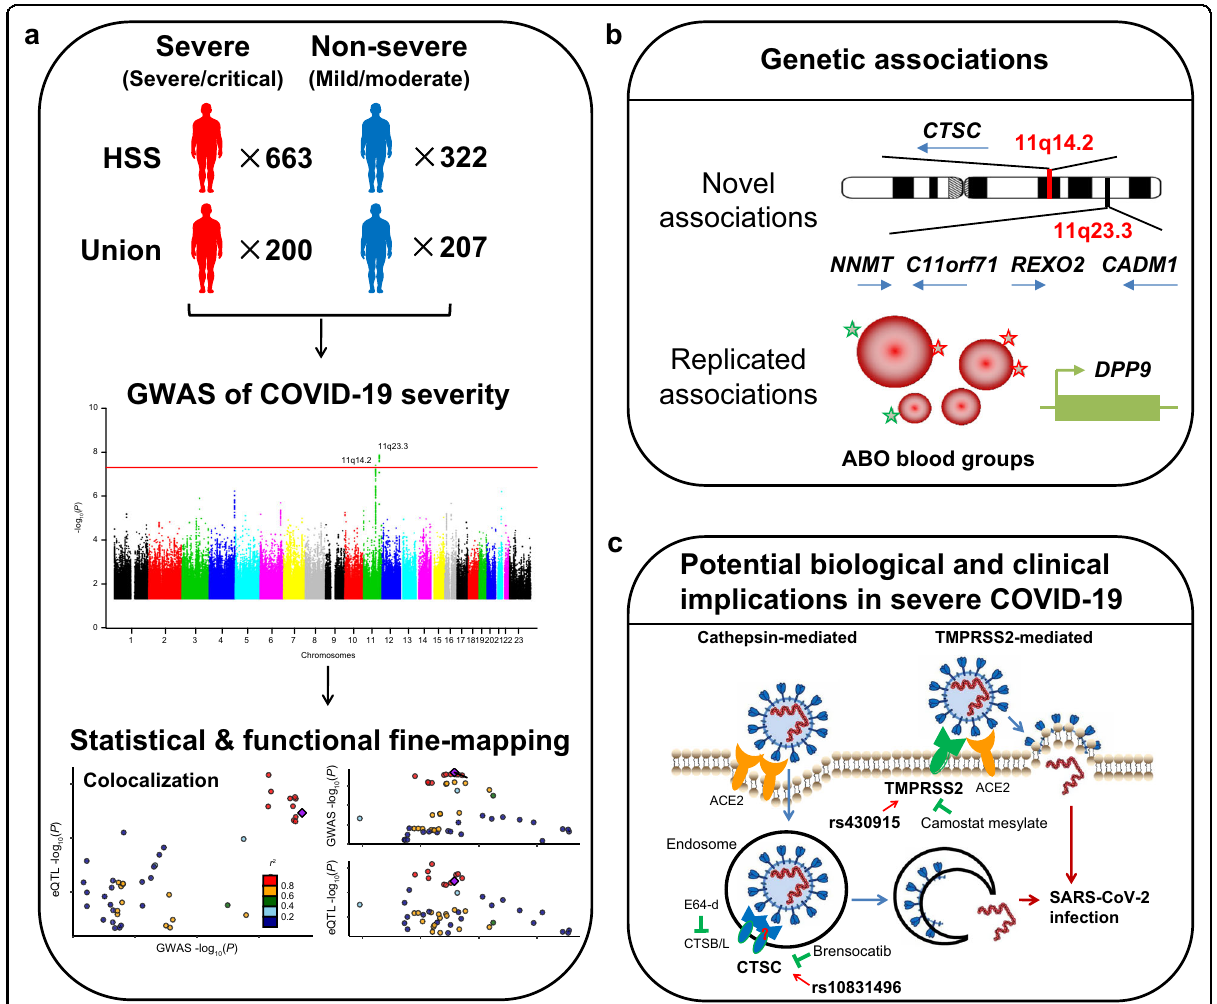
Fig. 1 Summary of the GWAS for COVID-19 severity in the Chinese population. a Analyses pipeline of this study. We performed a genome-wide association study (GWAS) on 863 severe or critical COVID-19 patients (cases) and 529 mild or moderate patients (controls) from two hospitals, Huoshenshan (HSS) and Union hospitals, Wuhan city, Hubei province, China (after quality controls). We also conducted statistical and functional fi ne- mapping analyses for the two loci that reached the genome-wide signi fi cance ( P = 5 × 10 − 8 ). eQTL, expression quantitative trait locus. b Main fi ndings of this study. We identi fi ed two novel loci (chromosome 11q23.3 and 11q14.2) to be signi fi cantly associated with COVID-19 severity ( P < 5 × 10 − 8 ). We also replicated two loci that were previously shown to be associated with COVID-19 (i.e. ABO blood groups at 9q34.2 and dipeptidyl peptidase 9 [ DPP9 ] at 19p13.3). c Potential biological and clinical implications in severe COVID-19 suggested by the genetic fi ndings in this study. A recent study has shown that SARS-CoV-2 can use the endosomal cysteine proteases Cathepsin B and L (CTSB/L) and the serine protease transmembrane serine protease 2 (TMPRSS2) for cell entry (through endocytosis or membrane fusion mechanisms, respectively), and the combination use of the CTSB/L inhibitor (E64-d) and TMPRSS2 inhibitor (camostat mesylate) can fully block the entry of SARS-CoV-2 into human cells. In this study, we have suggested that CTSC , which encodes an endosomal cysteine protease, to be a candidate susceptibility gene of COVID-19 severity (index SNP rs10831496). A phase III clinical trial “ STOP-COVID19 ” is running to evaluate whether the Cathepsin C (CTSC) inhibitor Brensocatib (DB15638) can help COVID-19 patients. In TMPRSS2 gene, we also detected a suggestive association signal (index SNP